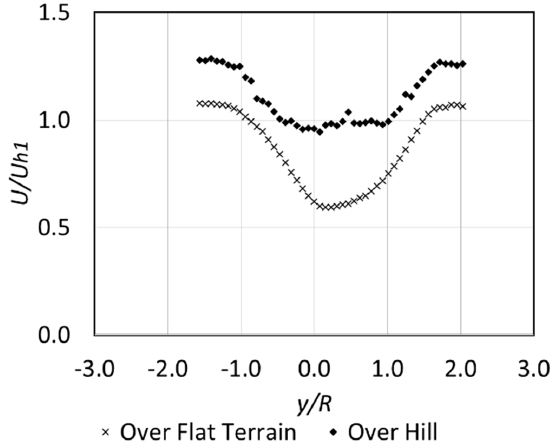
Figure 12. Comparison between configurations B and C at 6.09 D (wind turbine at x = − L , measurement at x = L ).